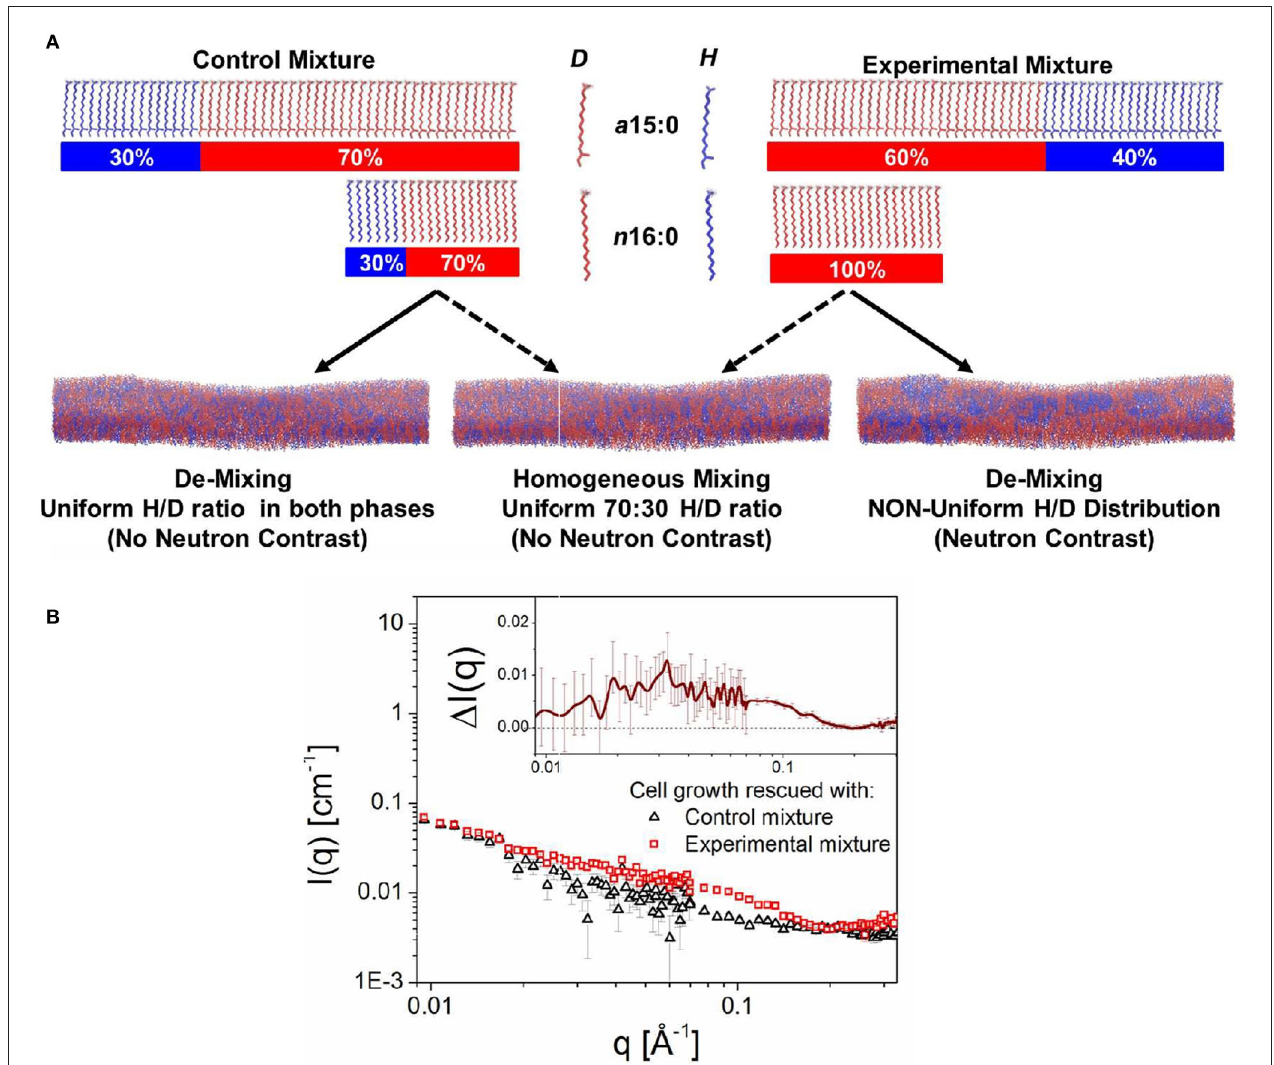
FIGURE 6 | Schematic showing the approach that was used to detect lipid domains in the PM of B. subtilis . The bacteria were genetically and chemically manipulated to contain only two fatty acids, namely the low temperature melting a15:0 and the high temperature melting n16:0. Note, that B. subtilis incorporates a15:0 at more than twice the amount of n16:0. (A) The control fatty acid mixture consisted of a15:0 and n16:0, each of ratio 30% protiated:70% deuterated. On the other hand, the experimental fatty acid mixture consisted of an isotopic distribution of 40:60 protiated:deuterated for a15:0 and 100% deuteration for n16:0. (B) Scattering curves from bacteria with control and experimental fatty acid mixtures. The excess scattering is shown in the inset to the figure. Figure adapted from Nickels et al.